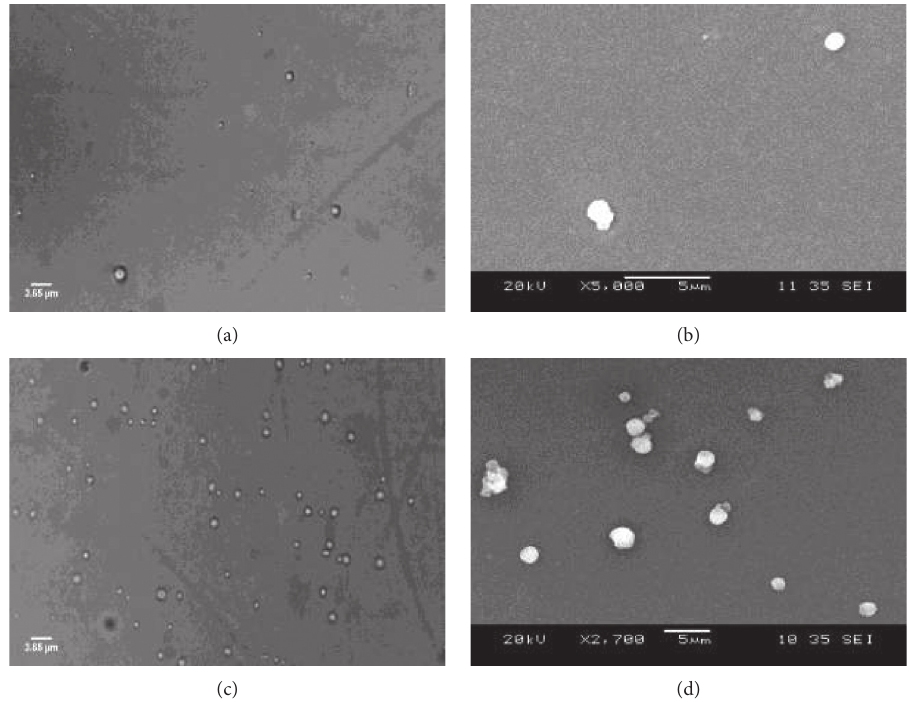
Figure 1: Particle size and morphology of alginate-based microparticles. Optical microscope (a) and SEM (b) images of AmB-loaded MCPs. Optical microscope (c) and SEM (d) images of blank microparticles